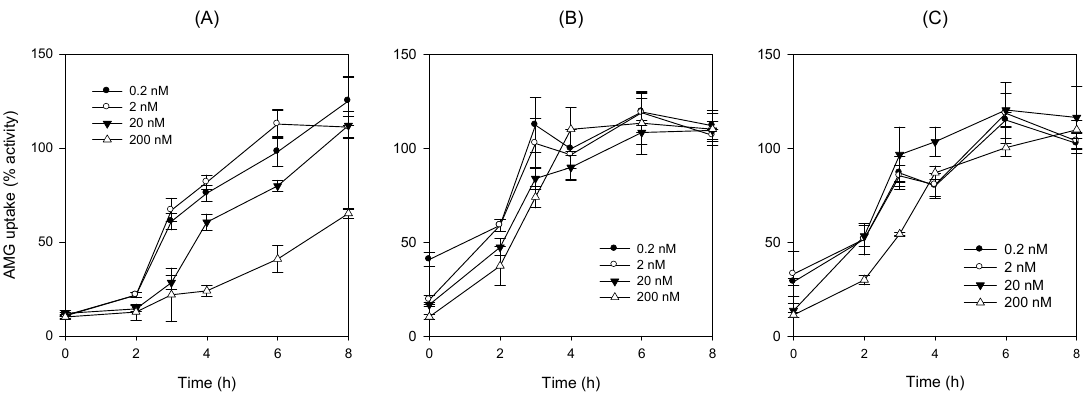
Figure 11. Recovery of SGLT2 transport function with different washout time following 24 h of incubation with ( A ) DWP16001, ( B ) dapagliflozin, and ( C ) ipragliflozin (0.2–200 nM) was measured through the uptake of [ 14 C]methyl-a-D-glucopyranoside (AMG) in CHO-SGLT2 cells. Each data point represents the mean±standard deviation of three independent experiments.